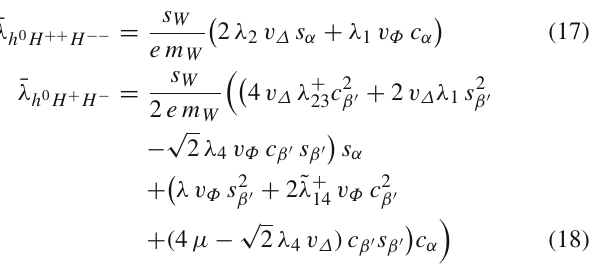
Fig. 3 Upper panel : the allowed parameter space of the HTM given by the variation of m H ±± (left) and m H ± (right) in (λ 1 ,λ 4 ) plane. In the lower panel: the correlation between ¯ λ h 0 H + H − and ¯ λ h 0 H ++ H −− follow-